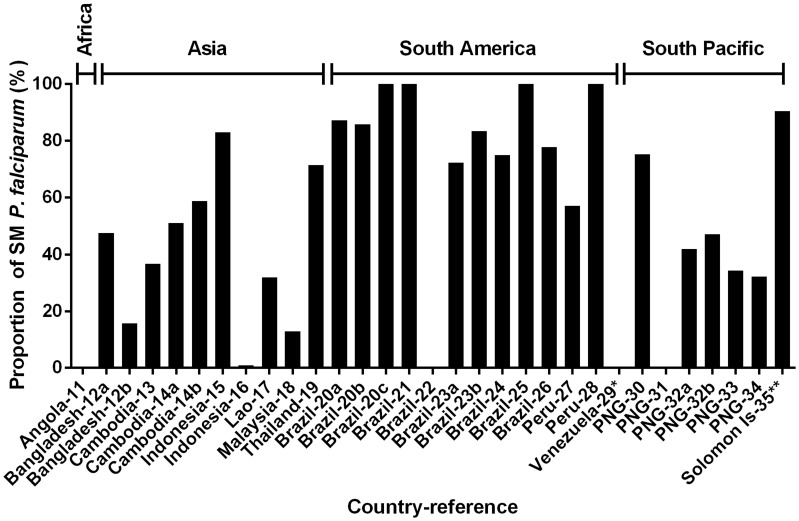
Relative proportion of sympatric SM (sub-microscopy) P. falciparum in cross-sectional surveys.Countries where data were collected and their corresponding references (detailed in Table 1) are shown on the x-axis.